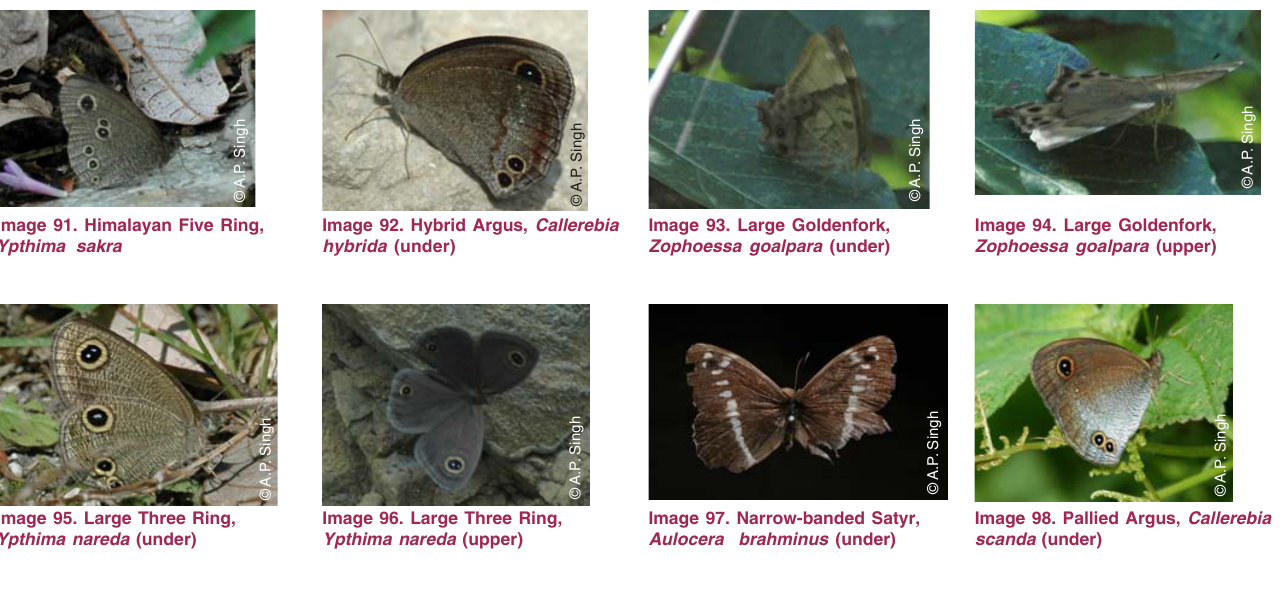
Image 96. Large Three Ring, Ypthima nareda (upper)